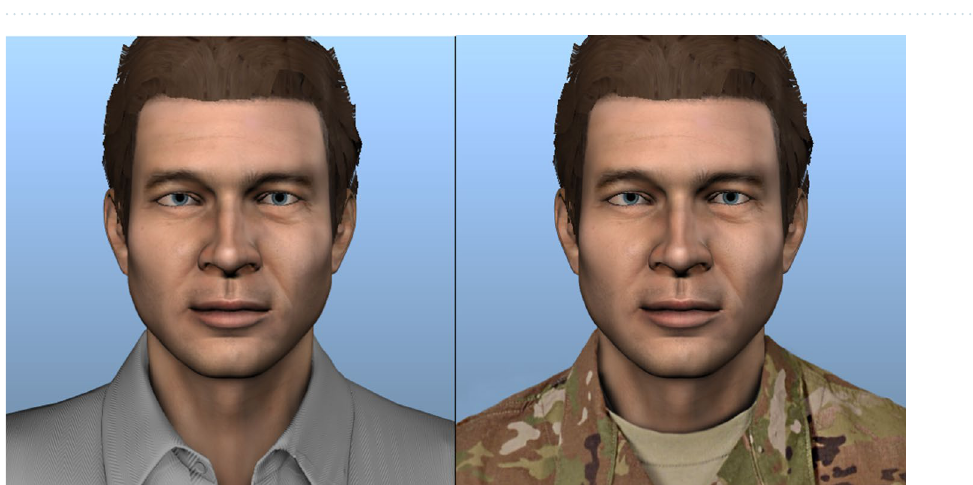
Figure 3. The agent in the civilian versus military